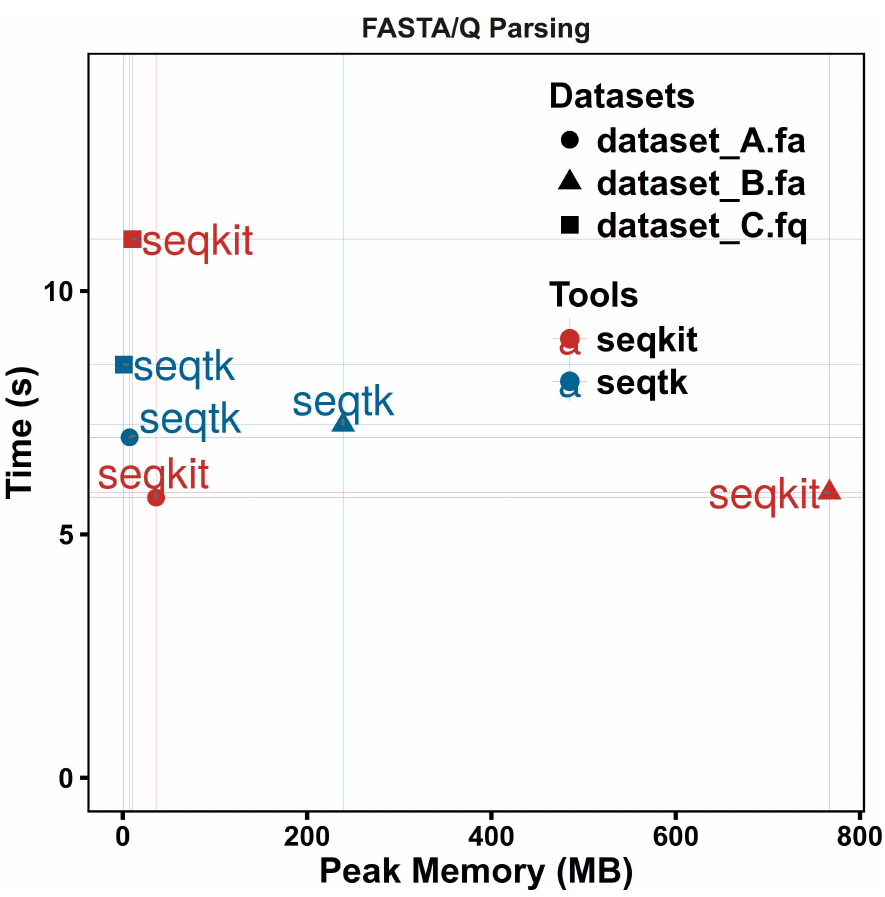
Fig 1. Performance comparison for FASTA/Q file parsing. Dataset A consists of 67,748 DNA sequences with averagelength of 41 Kb; dataset B is the human genome with 24 chromosomes, one mitochondrial sequence and 169 scaffolds and dataset C contains 9,186,045Illumina SE reads. All tests were repeated five times, and the average time or memory usage was computed. See supplementary data for details of test data and